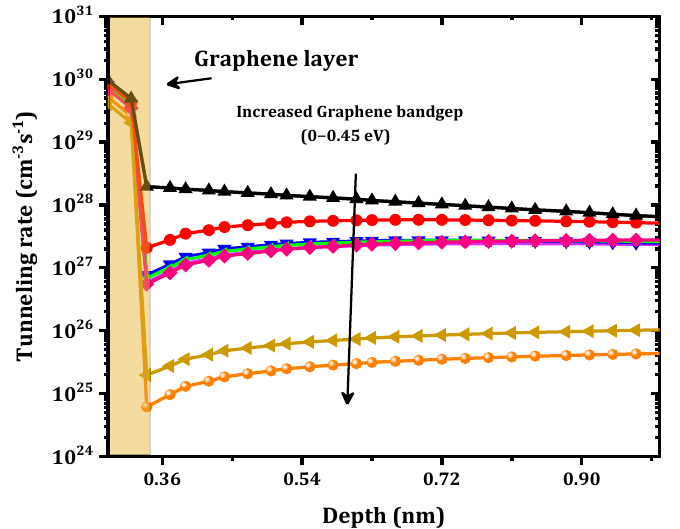
Figure 7. Variation in the tunneling rate versus the graphene bandgap under 2 V of forward voltage.